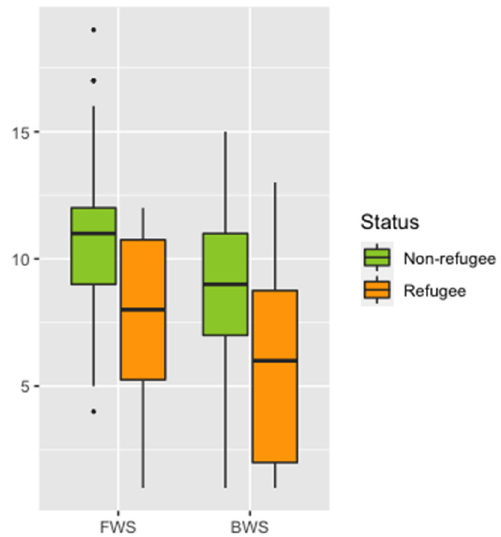
Table 1. Summary of the predictors involved in best fit models assessing the role of refugee status and individual variables on executive functions.